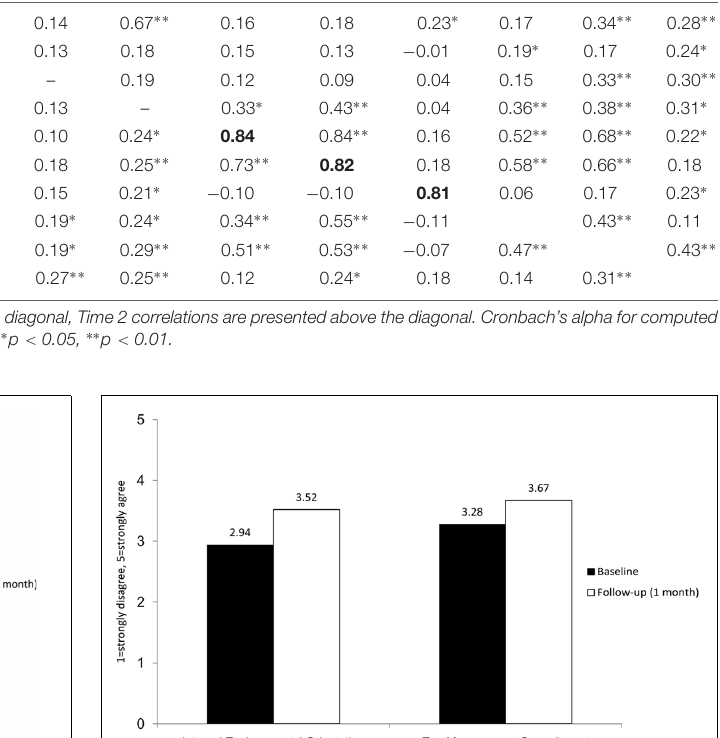
TABLE 1 | Mean, standard deviation, and bivariate correlations among self-reported variables a . Mean SD